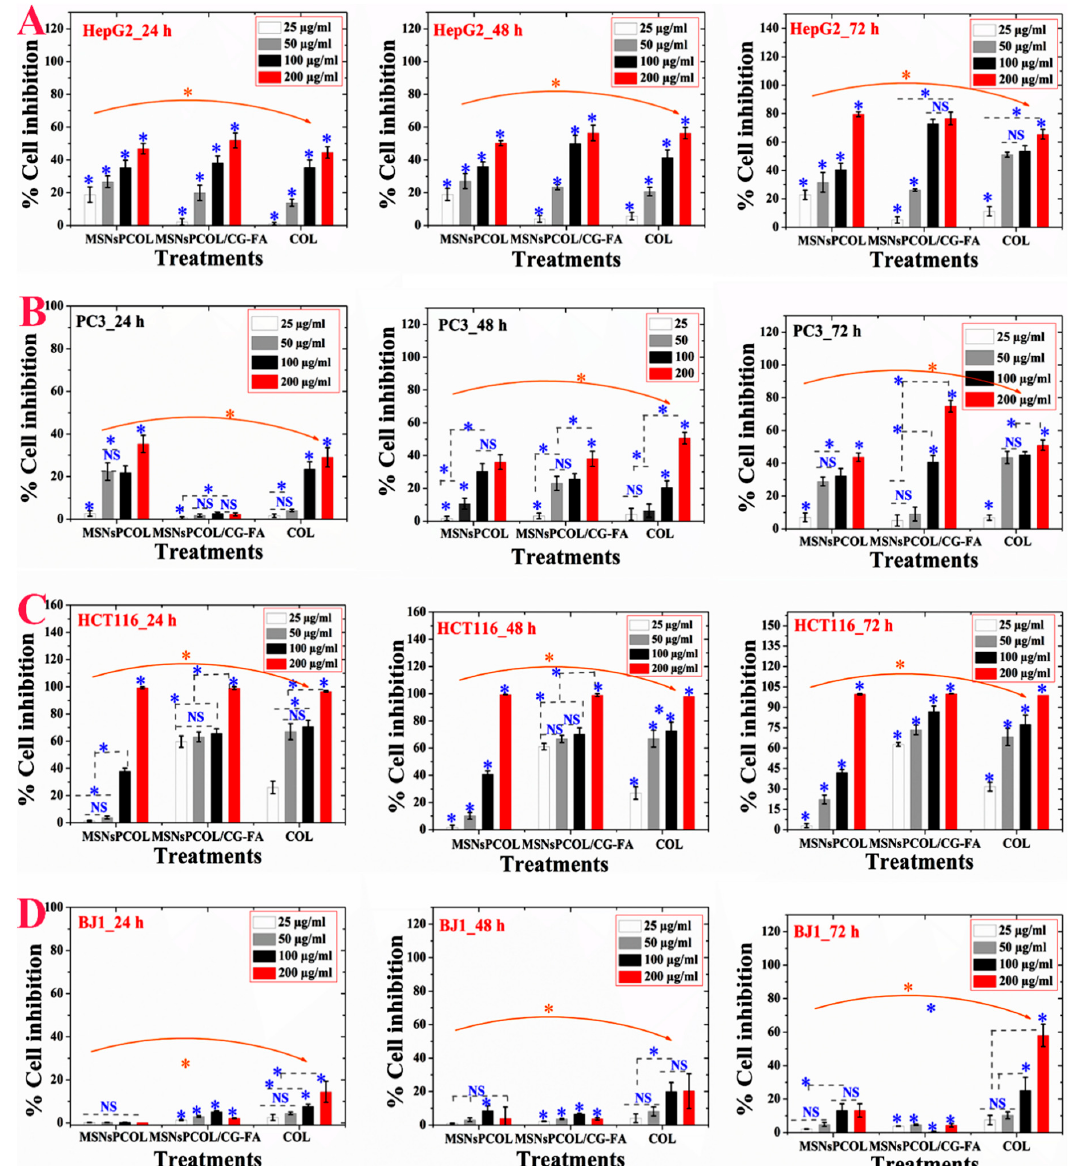
Figure 6. In vitro cytotoxicity (as percent inhibition) of the proposed delivery system in cancer and normal cells after 24, 48, and 72 h of incubation with cells. ( A ) Anticancer effects on HepG2 cancer cells. ( B ) Anticancer effects on PC3 cancer cells. ( C ) Anticancer effects on HCT116 cancer cells. ( D ) Anticancer effects on BJ1 normal cells. Note: A blue asterisk (*) indicates significant ( p < 0.05) differences between tested concentrations, whereas an orange asterisk (*) indicates significant differences between tested samples (nanoformulations and COL). NS, not significant. All data are expressed as mean ± SD.